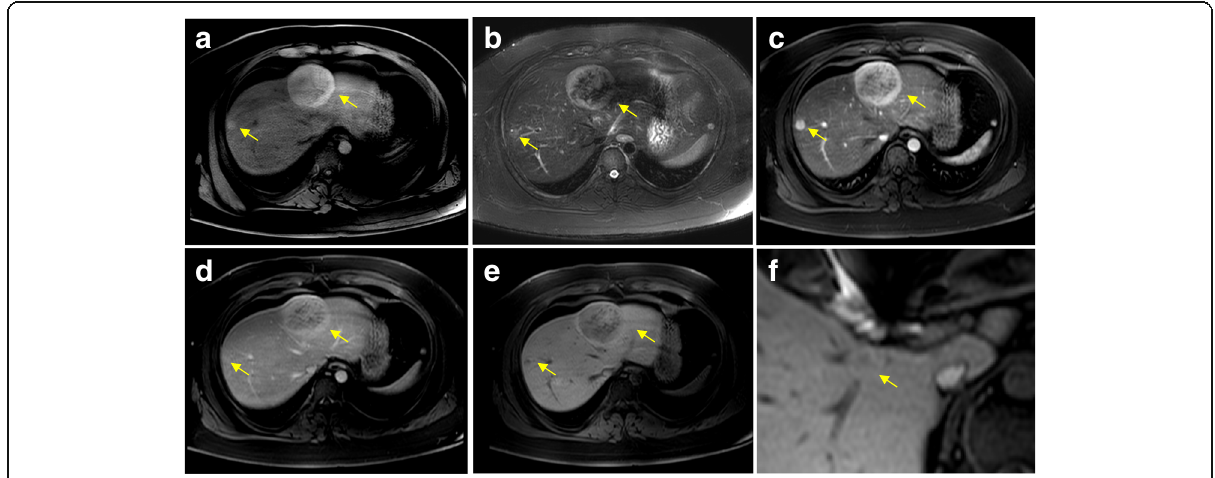
Fig. 2 Preoperative magnetic resonance imaging showing the presence of tumors. a T1-weighted magnetic resonance image (MRI) showing the two hyperintense tumors. b T2-weighted MRI showing the two tumors with mild hypertensity. c Gadoxetic acid-enhanced (EOB)-MRI showing the two tumors with enhancement in the arterial phase. d EOB-MRI showing the two tumors with prolonged partial enhancement in the late phase. e EOB-MRI showing the two tumors in segments 3/4 and 8 with low signal intensity in the hepatocellular phase. f EOB-MRI showing the one tumor in segment 1 with low signal intensity in the hepatocellular